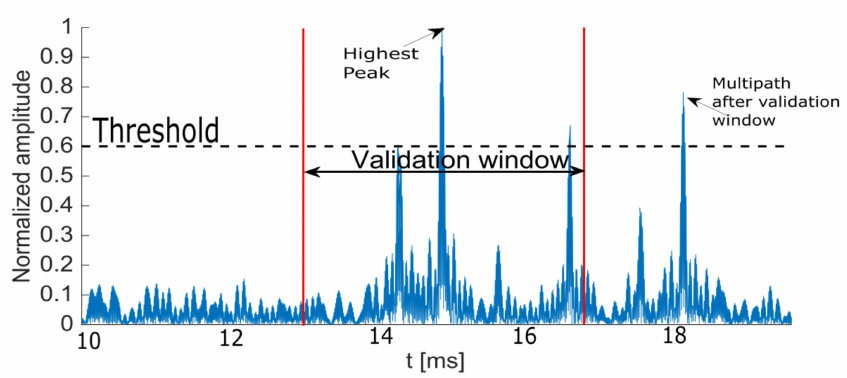
Figure 10. Example of a non-valid measurement after the peak detection